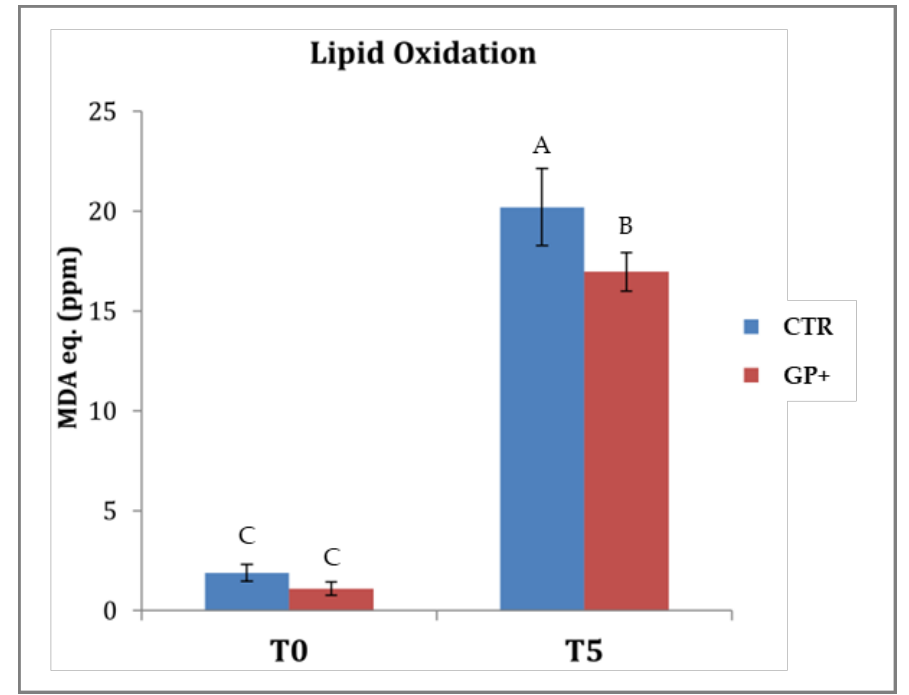
Figure 1. The results of the thiobarbituric acid reactive species test (TBARS-test) on cooked meat samples obtained from lambs fed with a standard diet (CTR) and lambs fed a dietary supplementation with grape pomace (GP+). The analysis was performed after cooking (T0) and after 5 days of storage (T5) at 4 ◦ C. A,B,C Different letters indicate significant differences due both to the storage time and to the feeding treatment ( p < 0.05).